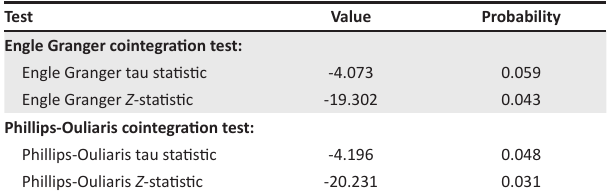
TABLE 3: Cointegration